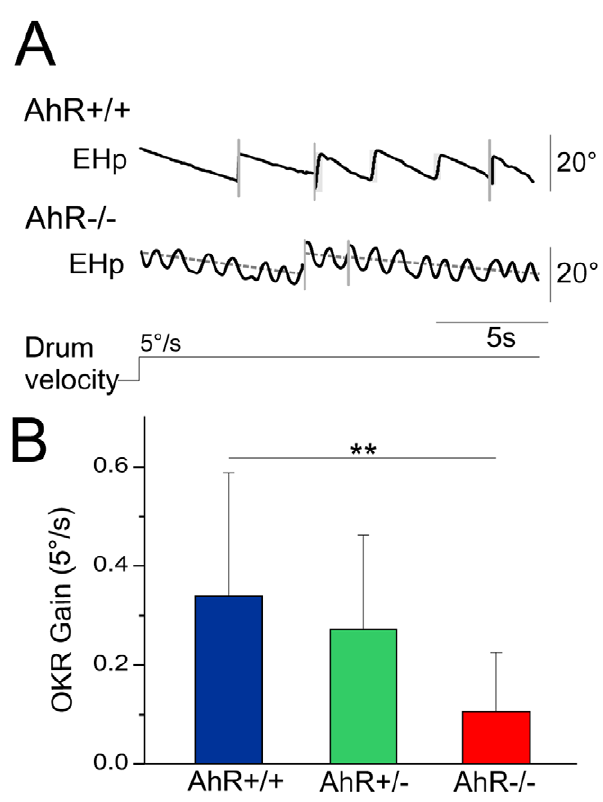
Figure 4. The OKR of AhR 2 / 2 mice is decreased. (A) Example of eye movements evoked in both AhR + / + and AhR 2 / 2 mice in horizontal position (EHp) during a rotation at 5 u /sec in light in counter-clockwise. (B) OKR gain at 5 u /sec. The OKR gain is significantly decreased in the AhR 2 / 2 mice compared with AhR + / + mice. The figure presents discontinuous time, as indicated by the vertical lines. Asterisk indicates statistical difference with p , 0.01, EHp: Eye Horizontal